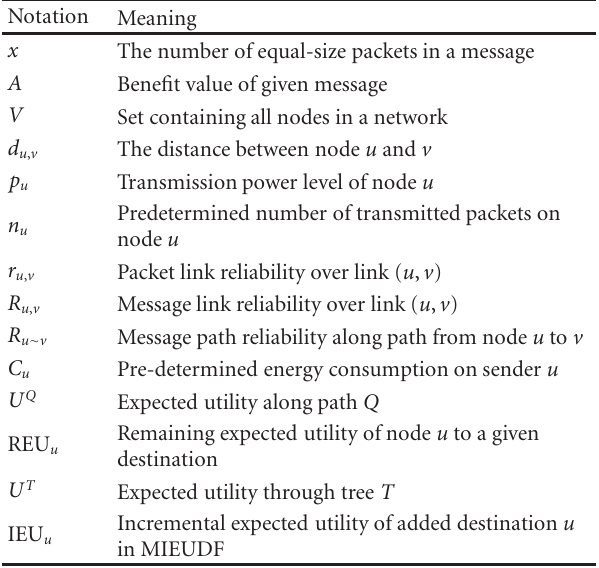
Table 1: Summary of key